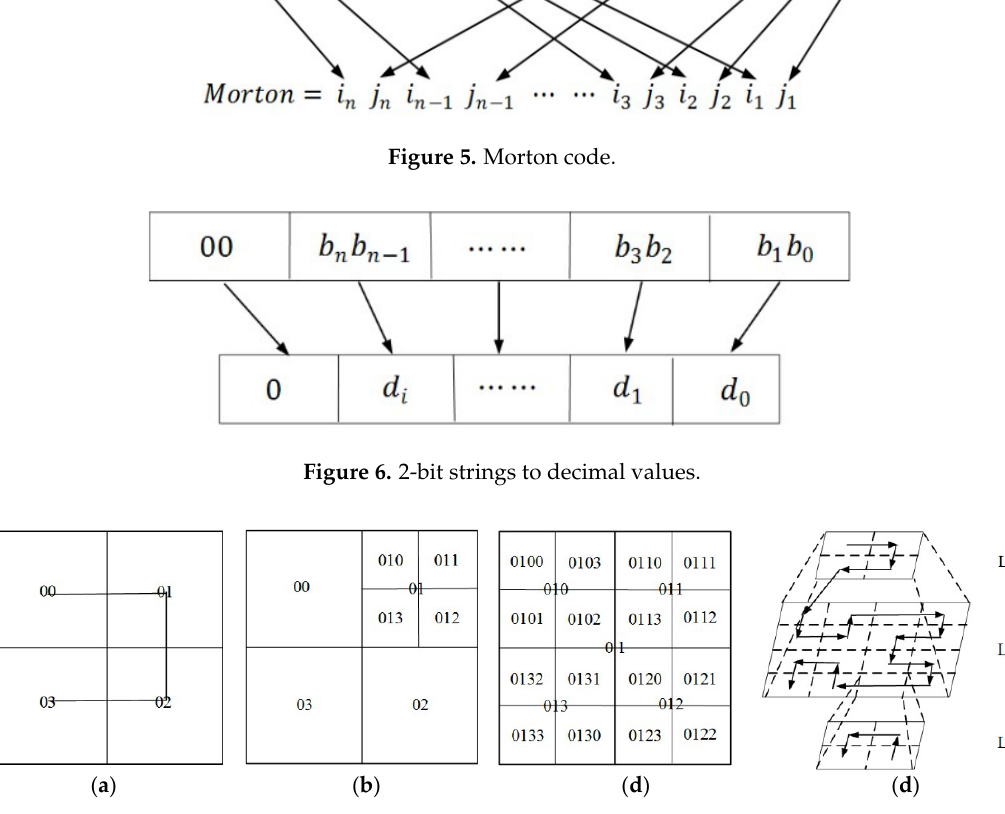
Figure 7. Hierarchical Hilbert grid and code. ( a ) Hilbert values of Level 1; ( b ) Hilbert values of Level 2; ( c ) local Hilbert values of Level 3; ( d ) hierarchical Hilbert grid and curve.